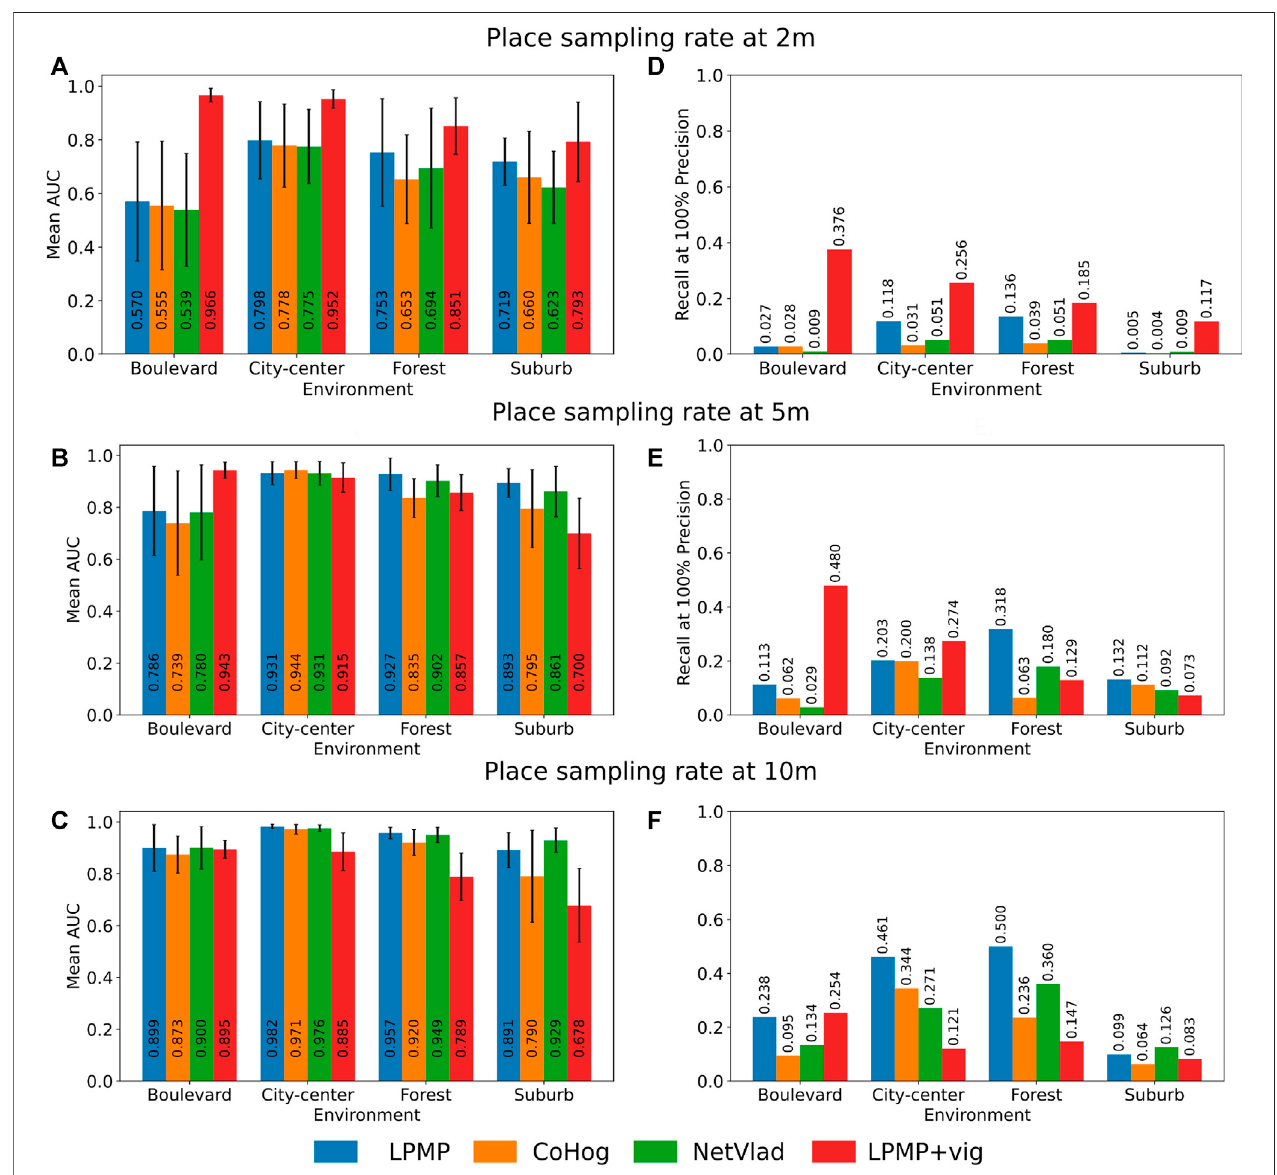
FIGURE8| Localization performanceofthe Log-Polar Max-Pi (LPMP), LPMP +Vig,CoHog, and NetVLAD models. Each model isevaluated incross-validation on each environment with three place sampling rates. Localization performance was assessed by computing standard precision/recall curves, summarized by the areas underthecurve (A – C) andtheirrecallat100%precision (D – F) .FortheLPMP+Vigmodel,whichautonomously learnswhentolearnanimageonasequence, thescore wascomputedusingthereplay-learnevaluation(RLE)method,amethodforestimatingthespacesencodedbythemodelthattakesintoaccountthenon-regularity of the representation. The standard deviation is indicated by a horizontal black bar